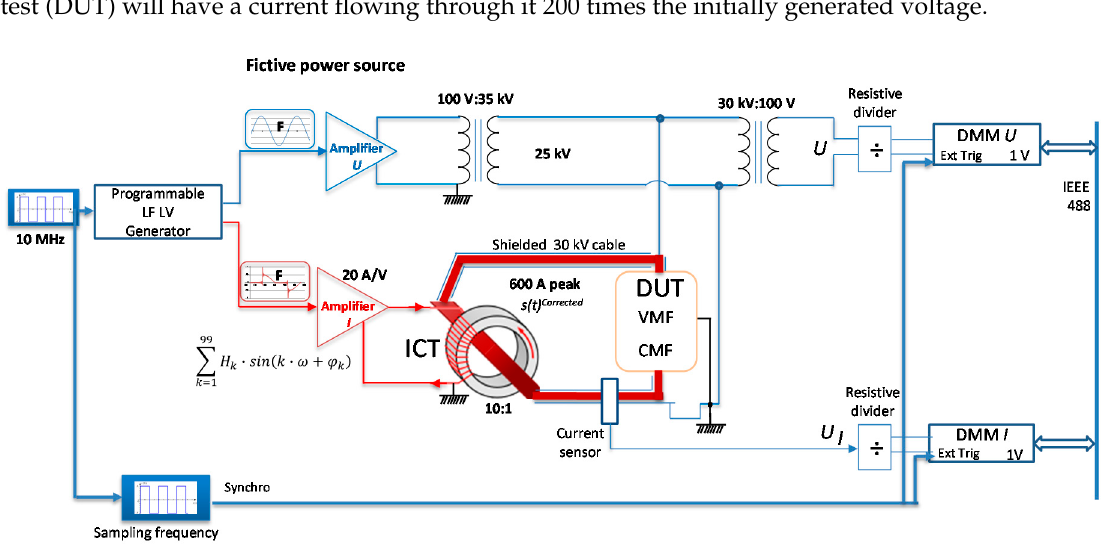
Figure 2. EMS calibration setup at LNE.